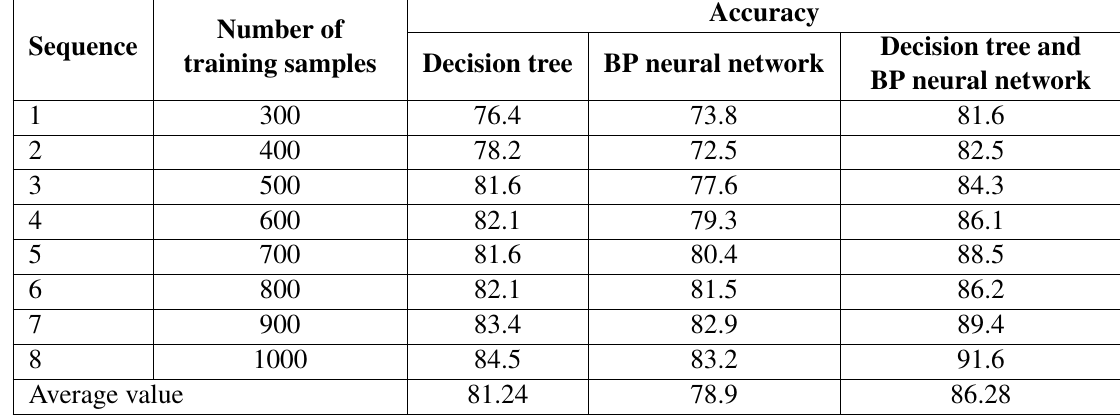
Table 7 Comparison of experimental